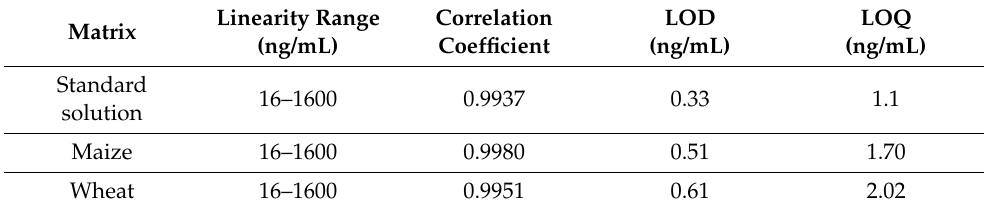
Table 1. The linearity, correlation coefficient, LOD, and LOQ for ZEN using the automated magneto- controlled pretreatment and signal conversion system in standard solution, maize, and wheat samples.